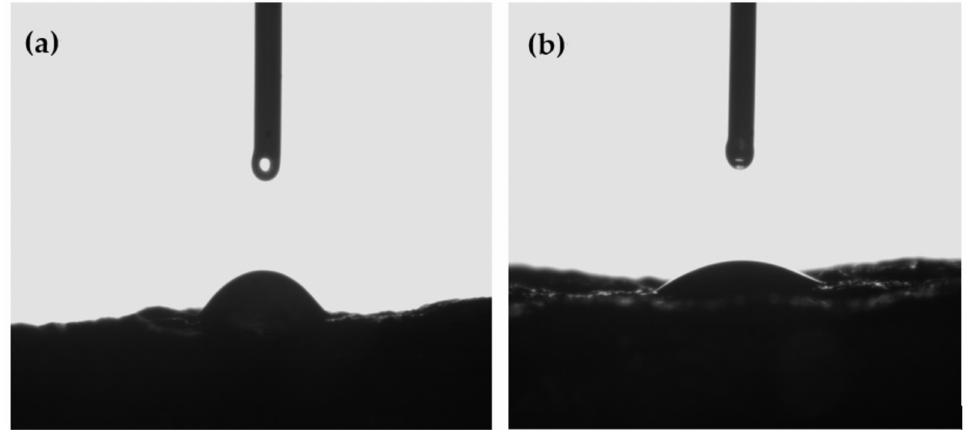
Figure 1. Image of contact angle measurements of the optimized formulation 2% Ch + 2% GTE + 0.1% FO ( a ) and 2% Ch + 2% GTE + FO 0.03% ( b ) applied on the beef